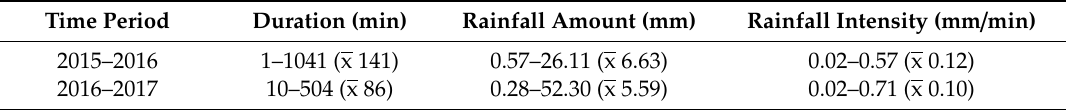
Figure 4. The functions (dependence) between the initial soil moisture and previous precipitation index determined according to the field measurements in the Slovak and Czech Republics. Table 4. Characteristics (minimum, maximum and mean value ( x ) ) of the selected 95 rainfall events between September 2015 and October